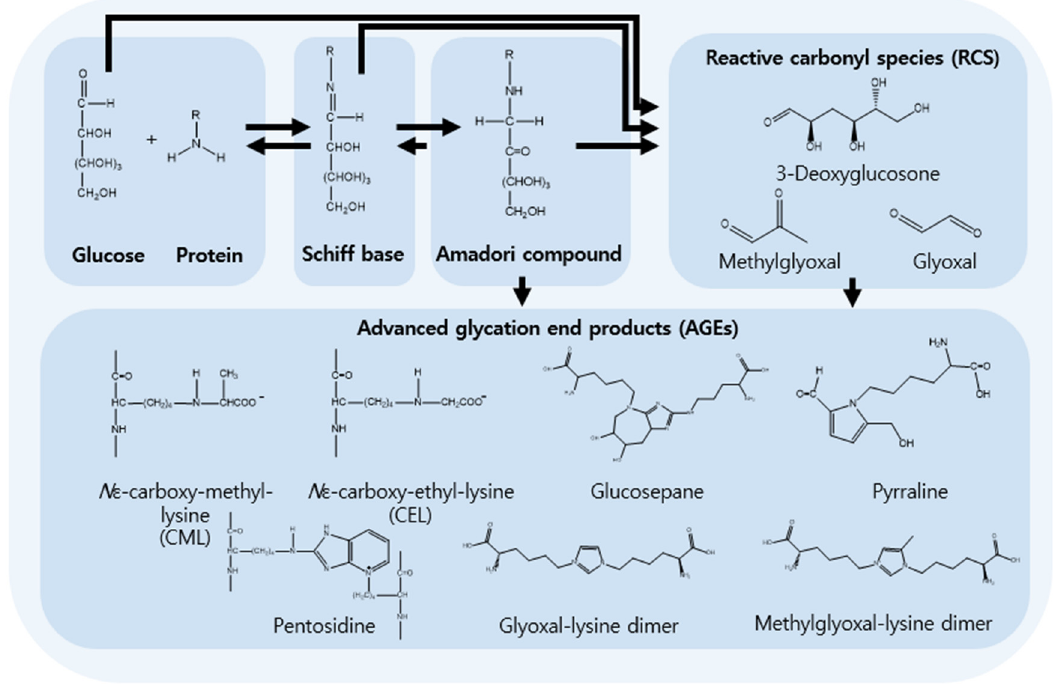
Figure 1: Process glycation related product generation. RCS ’ are initially covalently bonded, forming the early stages of glycation products ( Schi ff bases and Amadori compounds ) , and fi nally